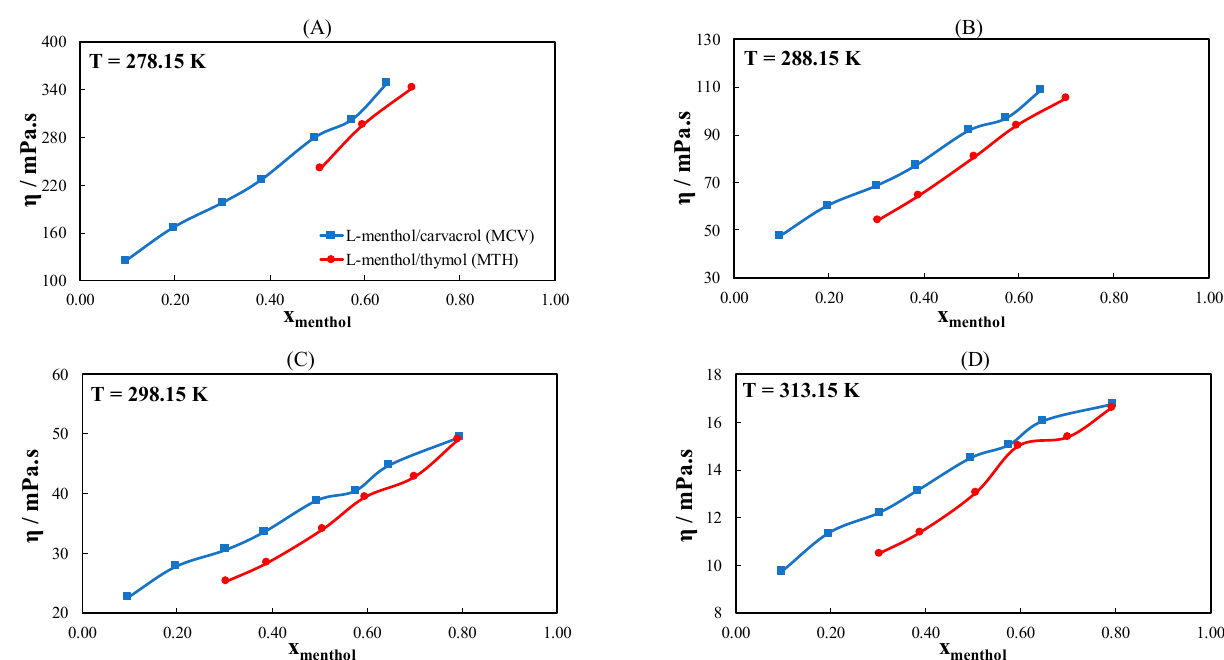
Figure 6. Viscosity of binary eutectic systems containing L -menthol with thymol or carvacrol as a function of L -menthol composition at ( A ) T = 278.15 K, ( B ) T = 288.15 K, ( C ) T = 298.15 K, and ( D ) T = 313.15 K.